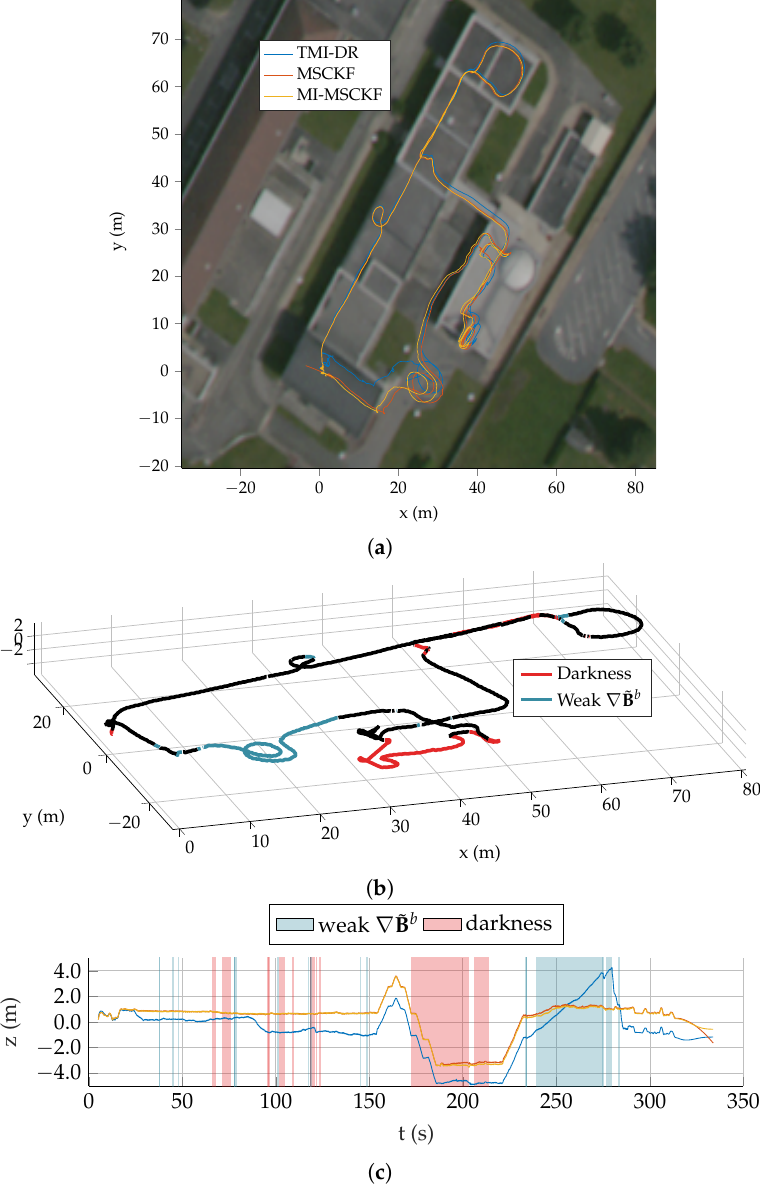
Figure 6. ( a ) Overview of trajectory Traj2 as reconstructed by the three filters. ( b ) Visualisation of dark areas and low-gradient areas over the entire trajectory surimposed on MI-MSCKF estimate. ( c ) Height profile of the three estimators on this